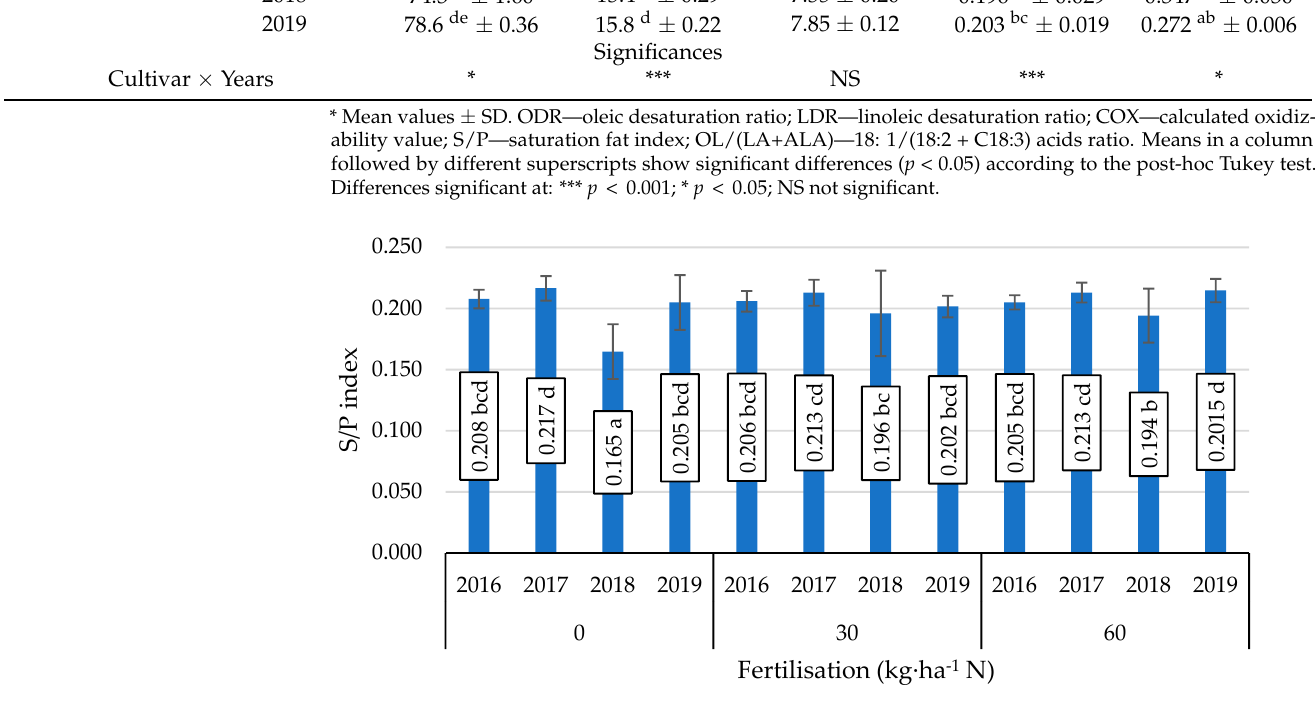
Figure 1. Value of the saturation fat index (S/P), mean values for interaction nitrogen fertiliser application × years. Mean values ± SD. Means followed by different superscripts show significant differences ( p < 0.05) according to the post-hoc Tukey test. Differences significant at: p <